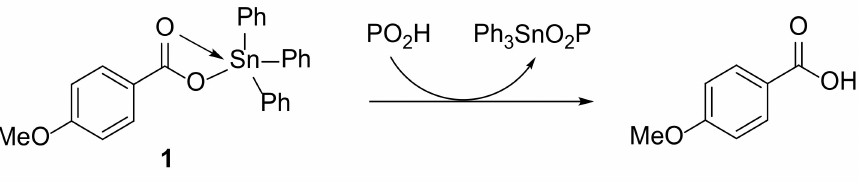
Scheme 4. Complex 1 acts as a peroxide